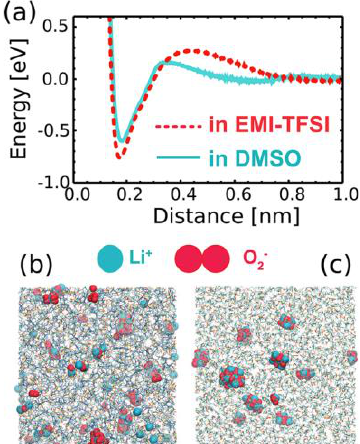
Figure 37. ( a ) Free energy as a function of Li + − O 2− aggregation and separation in EMI-TFSI and in DMSO under dilute condition. Snapshots of Li + − O 2− clusters formed in ( b ) EMI-TFSI and ( c ) DMSO after 200 ns. Adapted with copyright permission from Akagi et al. [62]. Copyright© 2016, American Chemical Society.